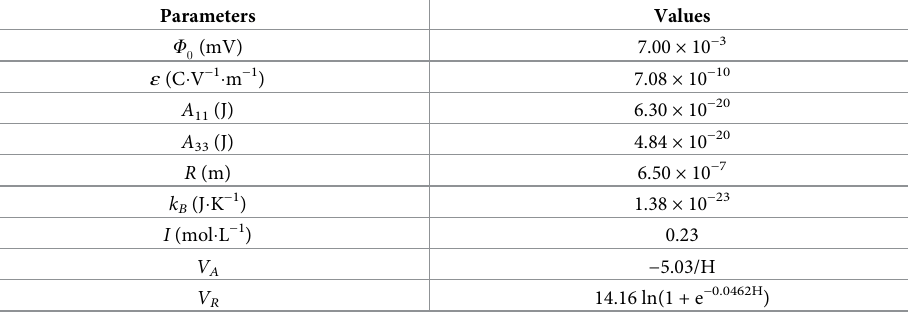
Table 3. The parameter values of HPG E-DLVO